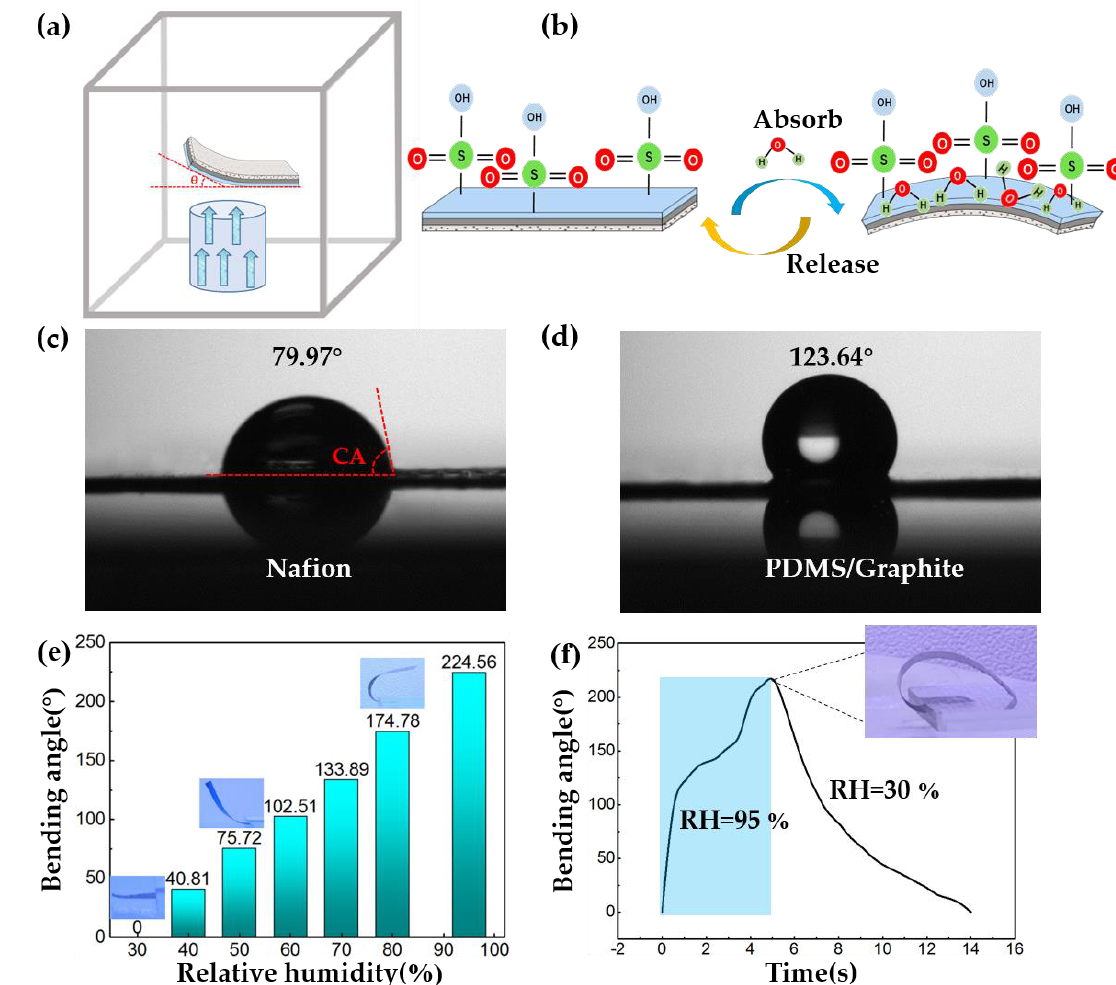
Figure 2. Humidity-responsive behavior of the multilayer membrane (the test ambient temperature was 25 °C). ( a ) Schematic diagram of the humidity deformation response testing. ( b ) Schematic illustration of the reversible deformation behaviors when humidity changes. ( c ) Photo of water droplet CA for Nafion film and ( d ) PDMS/Graphite film. ( e ) The maximum bending angle of the multilayer membrane under different relative humidity. ( f ) The time-dependent bending angle of the multilayer membrane under 95% (blue area) and 30% humidity stimulation.